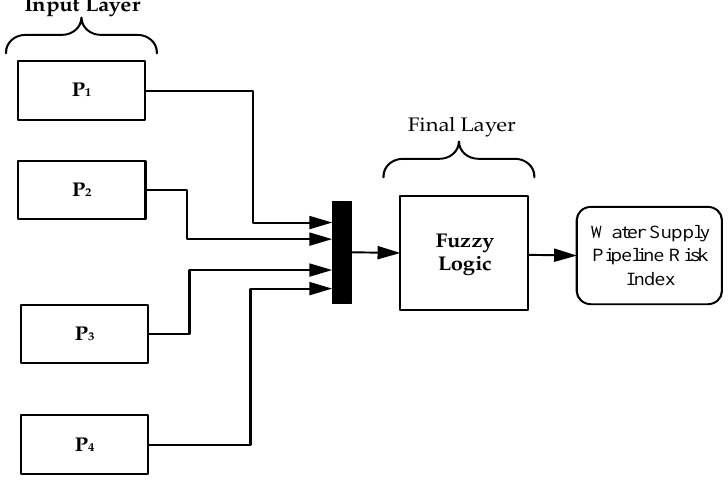
Figure 1. Conventional fuzzy inference model.